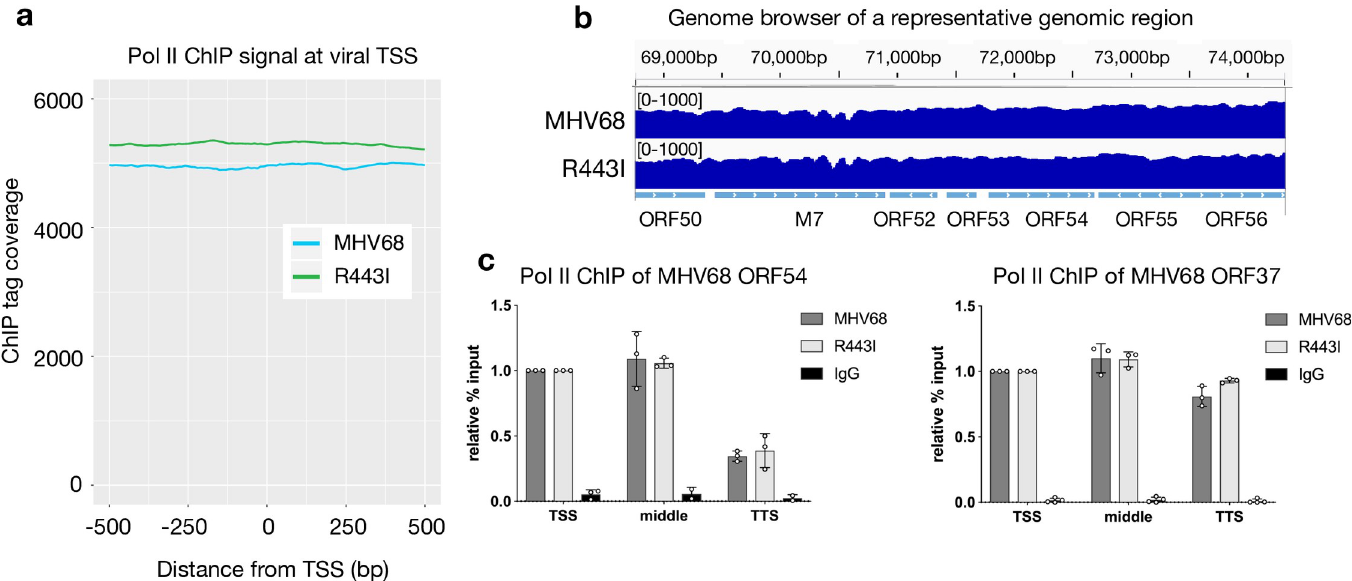
Fig 4. Viral genes are not susceptible to RNA decay-dependent Pol II repression. (A) Sequence tags were plotted as a histogram in 25 bp bins for -500 to +500 around the TSS. MHV68 WT (blue) and R443I (green) traces are shown from infected MC57G cells. (B) Pol II ChIP-seq coverage across 5.5 kb of the MHV68 genome for MHV68 WT and R443I. Alignment files were converted to tdf format and visualized in the IGV. (C) Pol II ChIP qPCR signal is similar across gene bodies. Three regions of the ORF54 and ORF37 gene were assayed by Pol II ChIP-qPCR during MHV68 WT or R443I infection to assess the relative levels of Pol II across the gene.